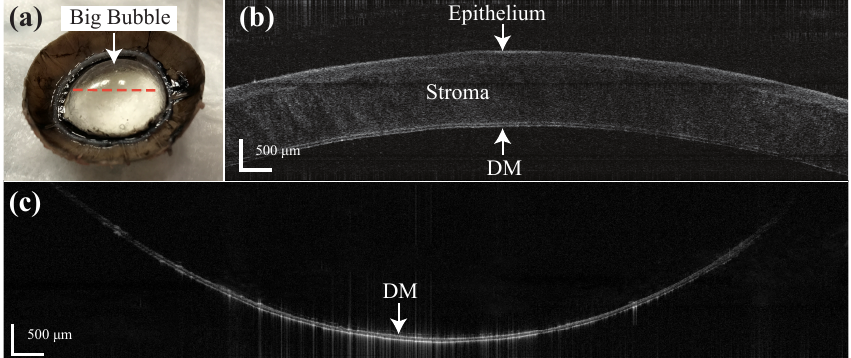
Figure 8. ( a ) Big bubble formation result by the distal sensor integrated needle on the bovine cornea. ( b ) B-scan of the bovine cornea before the insertion (epithelial side up). ( c ) B-scan of the big bubble (endothelial side up) on the labeled location (orange dotted line) in ( a